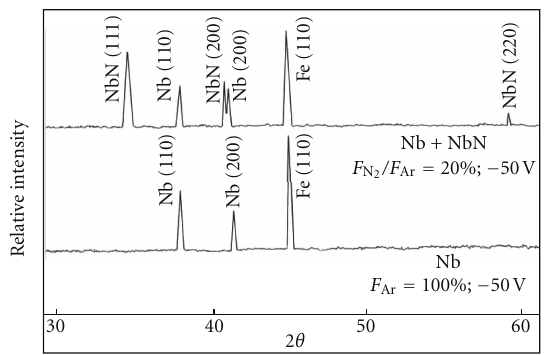
Figure 5: X-ray di ff raction patterns of Nb/MS and NbN/Nb/MS (Nb and NbN coatings were deposited in pure Ar and F N 20%, respectively; biasing was − 50 V for both).